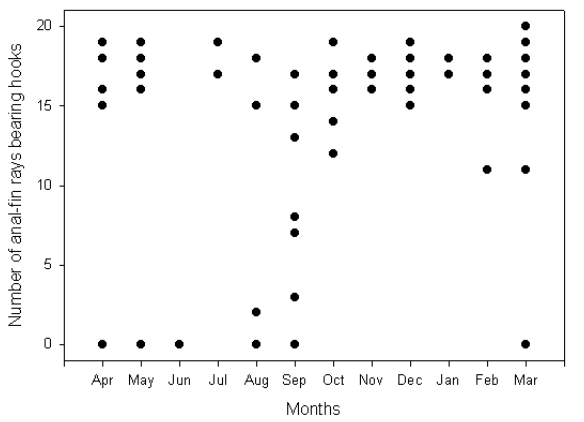
Fig. 2. Monthly variation of the number of anal fin rays bear- ing hooks in males of Aphyocharax anisitsi between April 2001 and March 2002 in the arroio do Salso, Rosário do Sul, RS, Brazil (each dot may represent more than one specimen). males that were probably hatched during the previous repro- ductive season. At the top, males that matured during previ- ous reproductive season or are maturing for the first